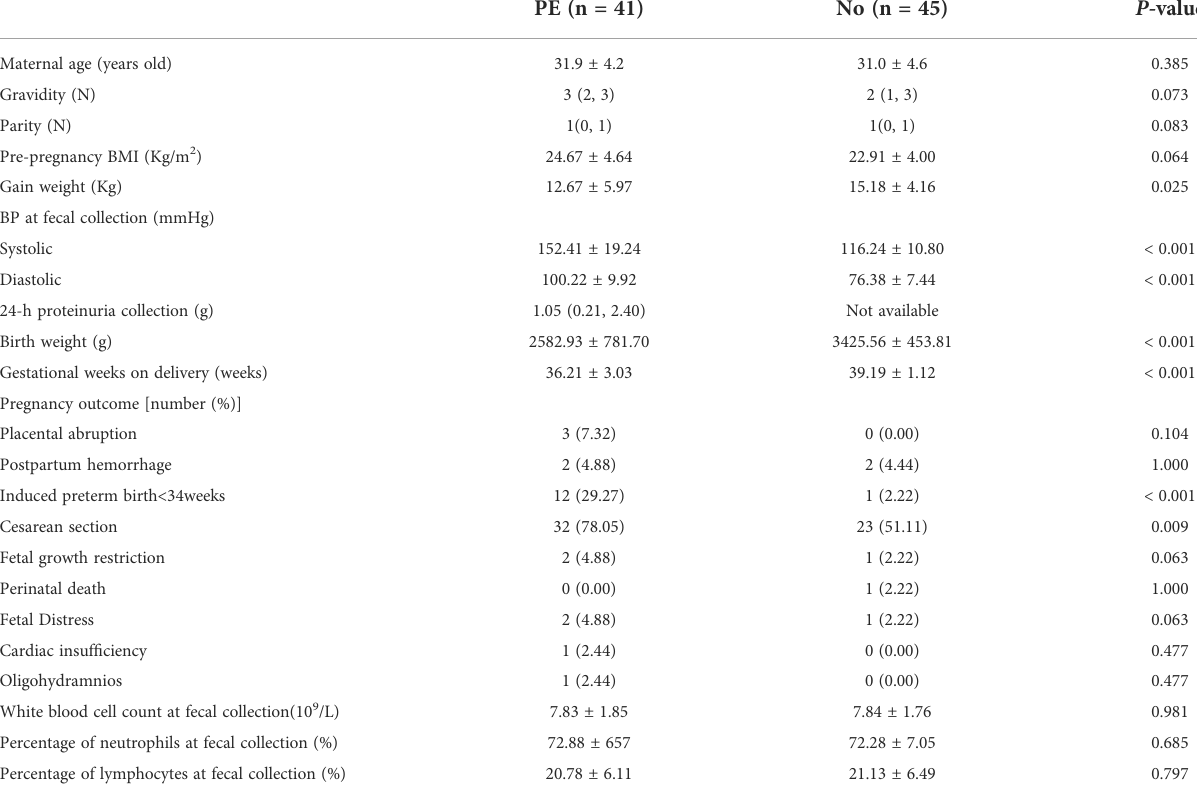
TABLE 1 Baseline characteristics of the PE and normal